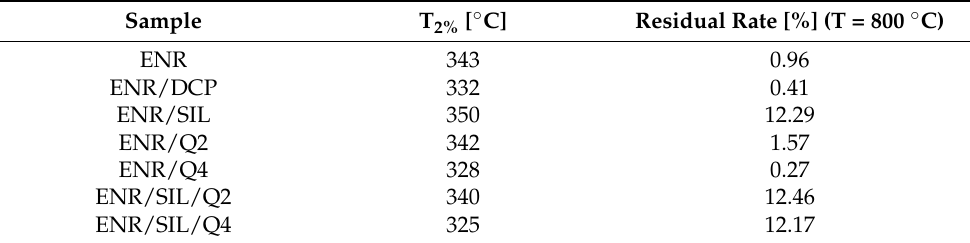
Figure 2. TGA ( a ) and DTG ( b ) curves of uncured ENR-50 and ENR-based composites crosslinked with quercetin, silica and combination of silica and quercetin. Table 1. Temperatures at maximum mass loss rate of the ENR-50-based composites and the residual rate [%] .